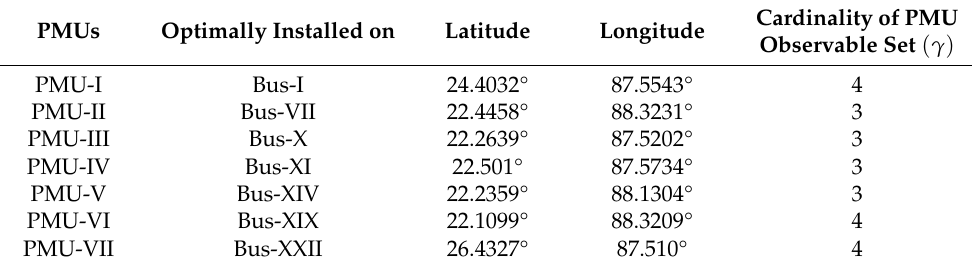
Figure 8. The locations of PMUs and the PDC in the West Bengal’s power grid. Table 2. Key design parameters of SCN topologies under case study.